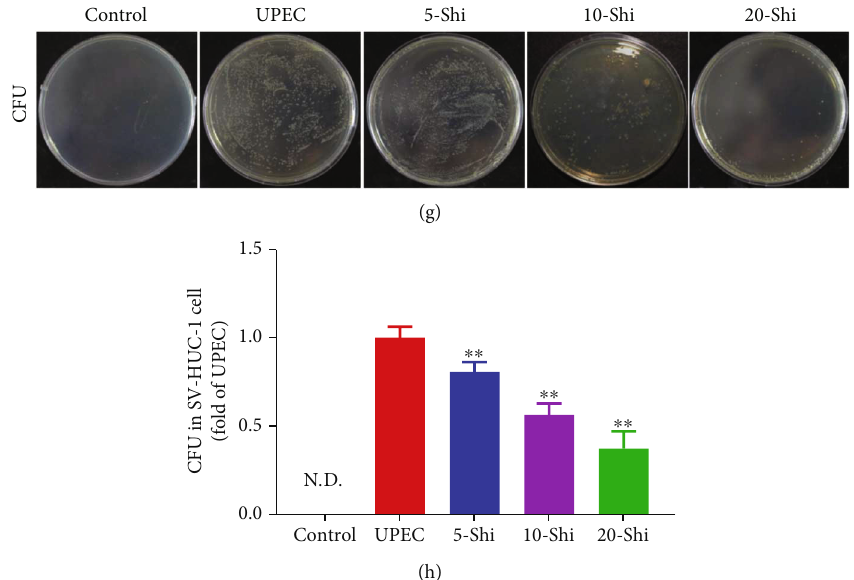
Figure 4: Shionone reduces in fl ammation and E. coli in SV-HUC-1 cells infected with urinary pathogenic E. coli . (a) The cell viability of each group. (b) The level of the in fl ammatory factor IL-1 β in supernatant of cell in each group. (c) The level of the in fl ammatory factor IL-6 in the supernatant of cell in each group. (d) The level of the in fl ammatory factor TNF- α in the supernatant of cell in each group. (e) Staining of cytoskeleton, E. coli , and nuclei in SV-HUC-1 cells of each group of cell, with the cytoskeleton stained for phalloidin in red, E. coli in green, and nuclei stained for DAPI in blue. (f) Immuno fl uorescence intensity ratio of E. coli and DAPI. (g) Bacterial colony counts of each group. (h) Histogram statistics of bacterial CFU of each group. Compared with the control group, # means p < 0 : 05 and ## means p < 0 : 01 . Compared with the UPEC group, ∗ means p < 0 : 05 and ∗∗ means p < 0 : 01